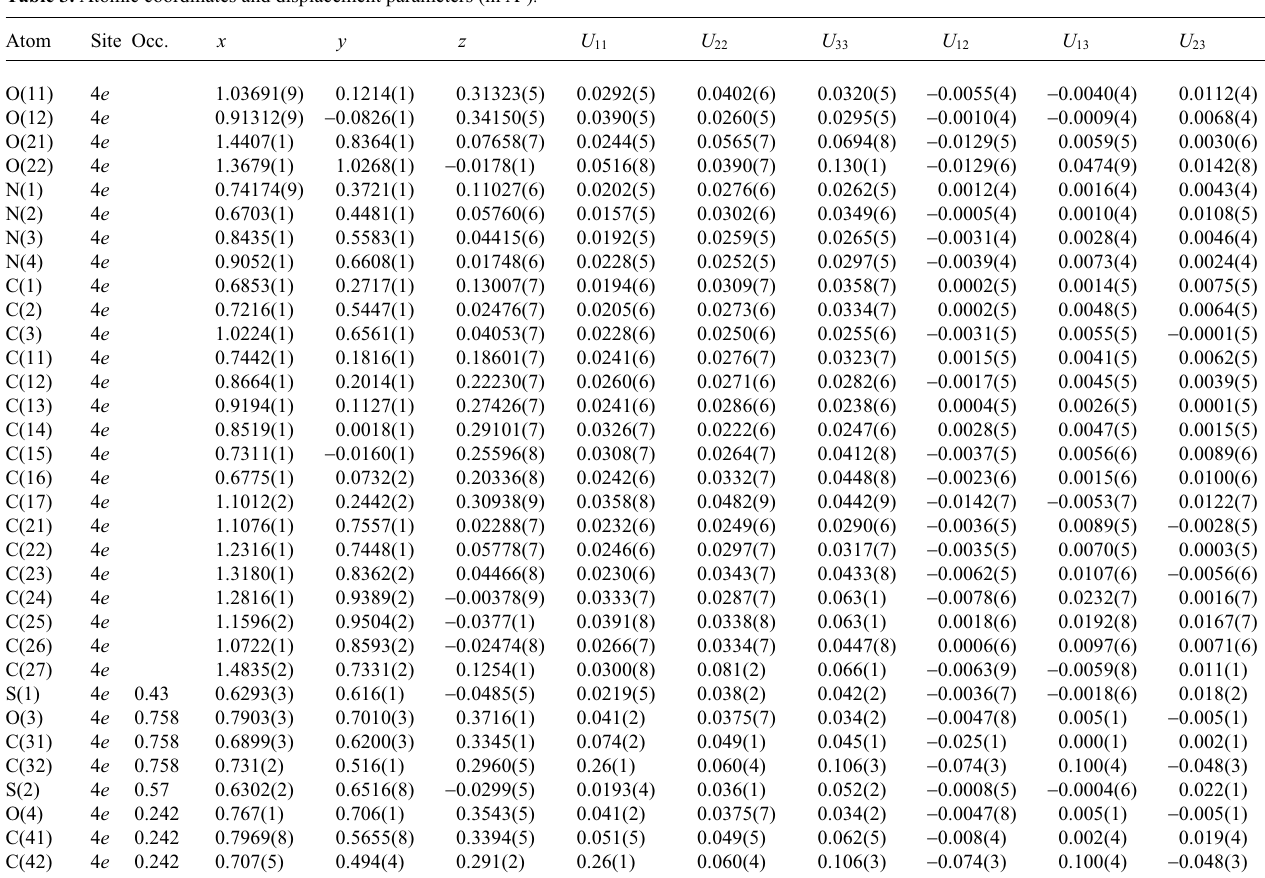
Table 3. Atomic coordinates and displacement parameters (in Å 2 ) . Atom Site